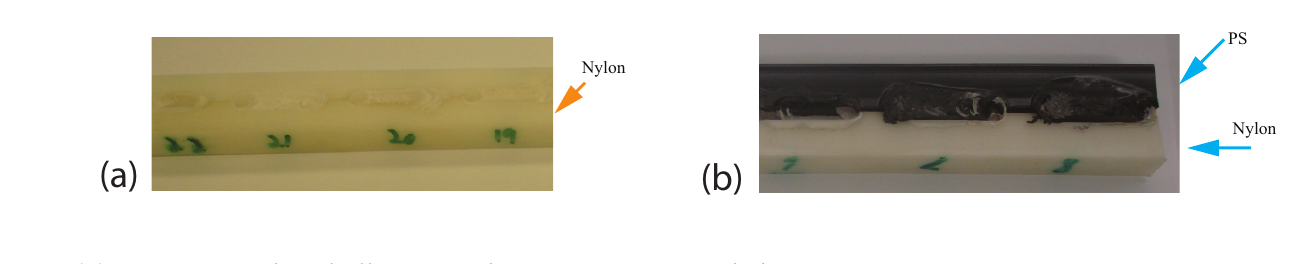
Figure 13 . Friction stir processed composites; (a) nylon-nylon laminate, (b) nylon-polystyrene laminate.